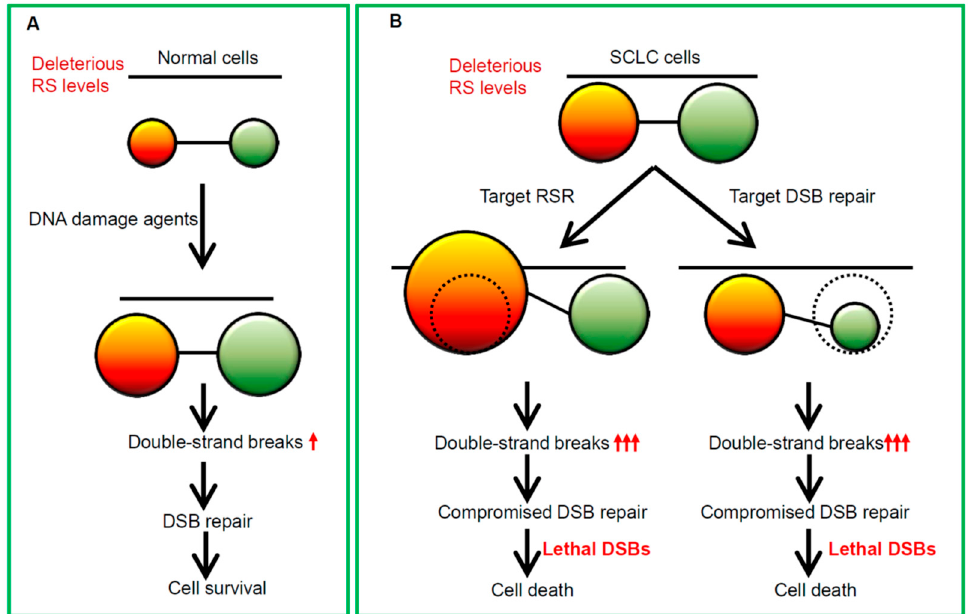
Figure 3. The rationales for targeting RSR and DSB repair in SCLC. ( A ) In normal cells, an elegant balance between the endogenous replication stress and competent DNA damage response pathway maintains genome integrity. ( B ) In SCLC cells, targeting RSR leads to intolerable replication stress (RS), thus leading lethal RS levels and DSBs that cannot be fixed by SCLC cells. Similarly, perturbation of DSB repair system results in compromised DNA damage repair and lethal DSBs that cannot be fixed by SCLC cells. Red arrow indicates an increase of DSBs.